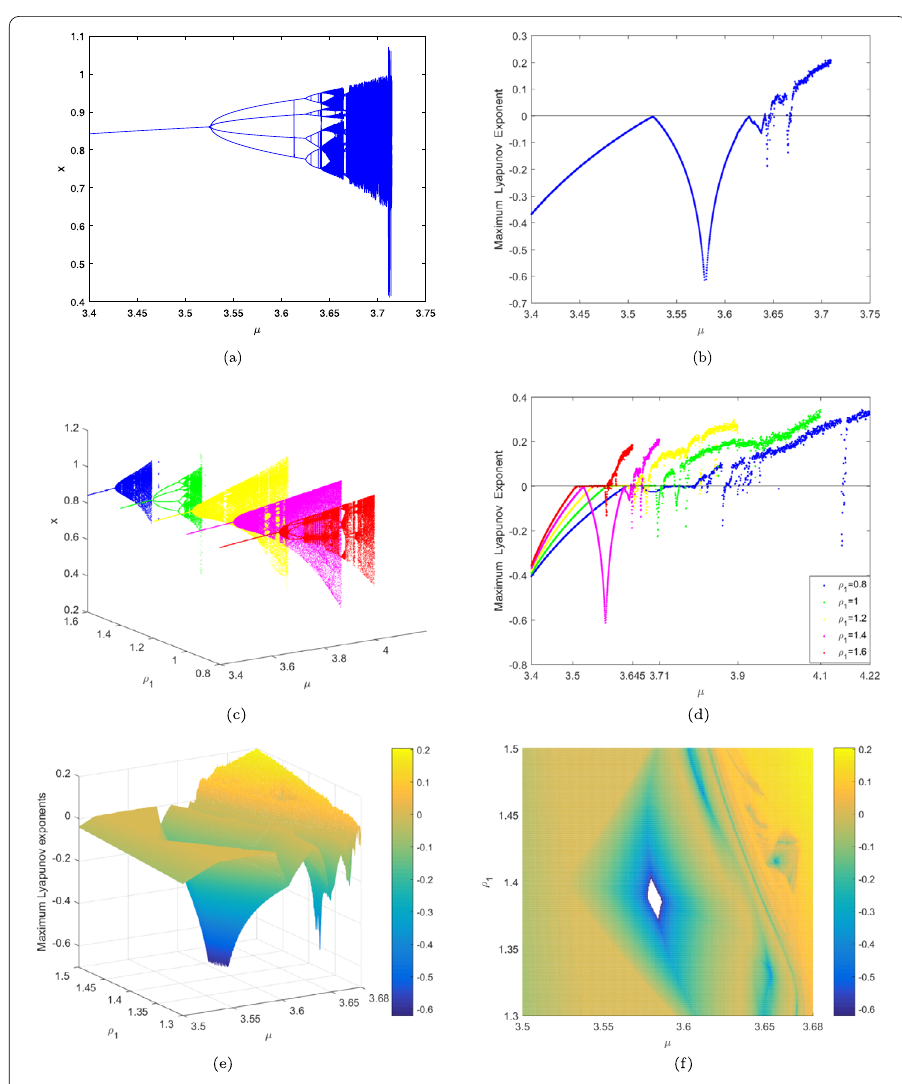
Figure 6 ( a ) Bifurcation diagram of map (2) in ( μ , x ) space for ρ 1 = 1.4, ρ 2 = 0.6 the initial value is (0.87,0.4). ( b ) MLE corresponding to (a). ( c ) Bifurcation diagram of map (2) in ( μ , ρ 1 , x ) space for ρ 2 = 0.6 ( d ) MLE corresponding to (b). ( e ) MLE corresponding to (b). ( f ) MLE corresponding to